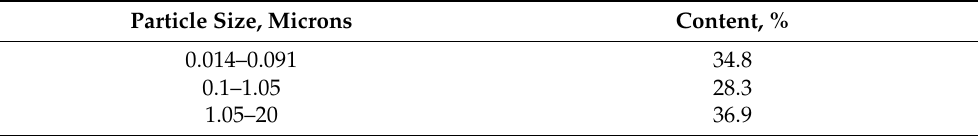
Figure 1. Granulometric composition of the dispersed phase of the electrically conductive additive. Table 1. Distribution parameters of the granulometric composition of the electrically conductive additive, in % by weight.